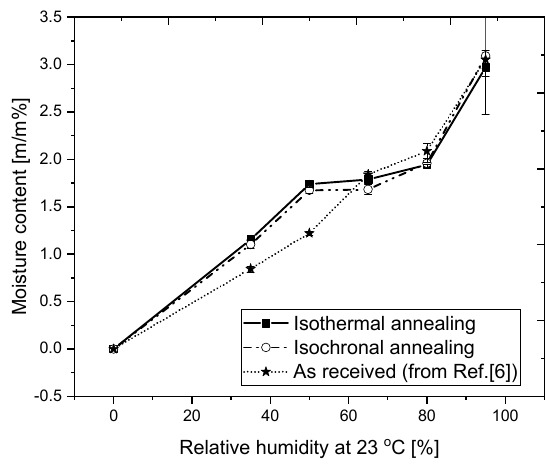
Figure 1. The sorption isotherm graphs.